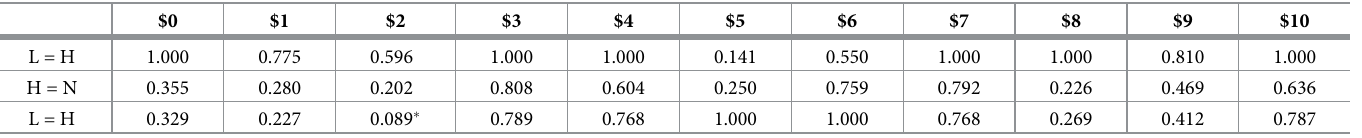
Table 4. Two-sided Fisher p -values.